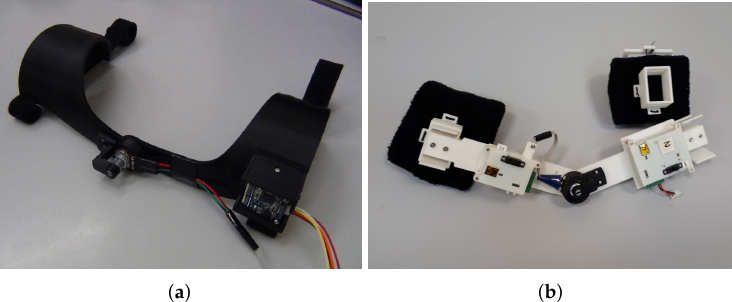
Figure 4. Evolution of the potentiometer and IMU sensor holder designs: ( a ) the 7-DOF double-arm system (Phase 2) and ( b ) the final 7-DOF system (Phase